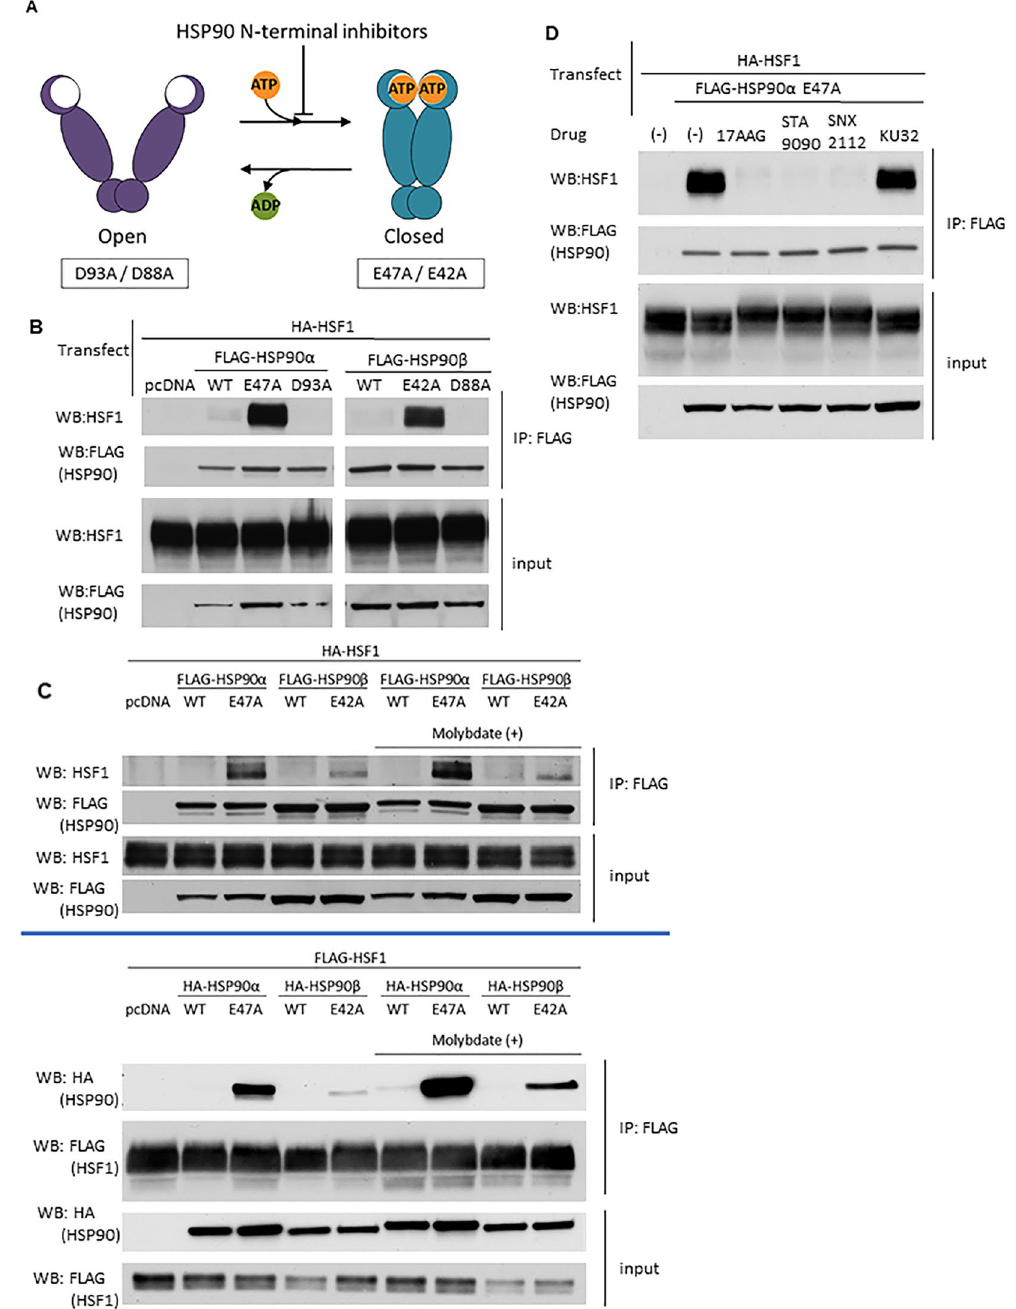
Figure 1. HSF1 is bound by HSP90 in the “closed” conformation. ( A ) HSP90 ATP-driven conformational cycle. HSP90 α E47A/HSP90 β E42A mutants bind ATP but cannot hydrolyze it and remain trapped in the “closed” N-domain dimerized conformation. Conversely, HSP90 α D93A/HSP90 β D88A mutants do not bind ATP and remain trapped in an “open” N-domain undimerized conformation. ( B ) HSF1 interaction with HSP90 “closed” and “open” mutants. HEK293 cells were co-transfected with HA-HSF1 and with each FLAG-HSP90 construct, harvested and analyzed for HSF1/HSP90 association by anti-FLAG IP - HSF1 WB. Pull-down experiments were repeated at least twice. ( C ) Reproducible and reciprocal HSF1 interaction with “closed” HSP90 α E47A and HSP90 β E42A mutants in the presence and absence of MoO4. Interactions were assessed by anti-FLAG (HSP90) IP - HSF1 WB (top panel) or anti-FLAG (HSF1) IP–HA (HSP90) WB (bottom panel). Pull-down experiments were repeated at least twice. ( D ) Effect of HSP90 inhibitors on HSF1-HSP90 α E47A interaction. HEK293 cells were transfected with HA-HSF1 along with FLAG-HSP90 α E47A, treated with N-terminal or C-terminal HSP90 inhibitors for 4 hours and analyzed by anti-FLAG (HSP90) IP- HSF1 WB. Pull down experiments were repeated at least twice. Full blots used to create cropped figure panels are shown in Supplementary Figure